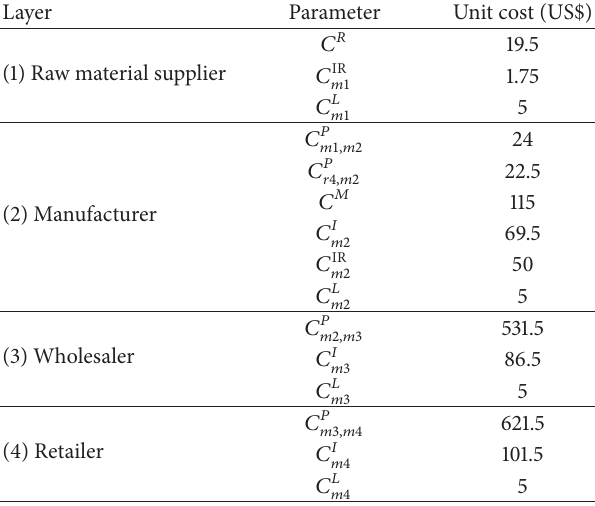
Table 2: Estimates of manufacturing chain unit costs.